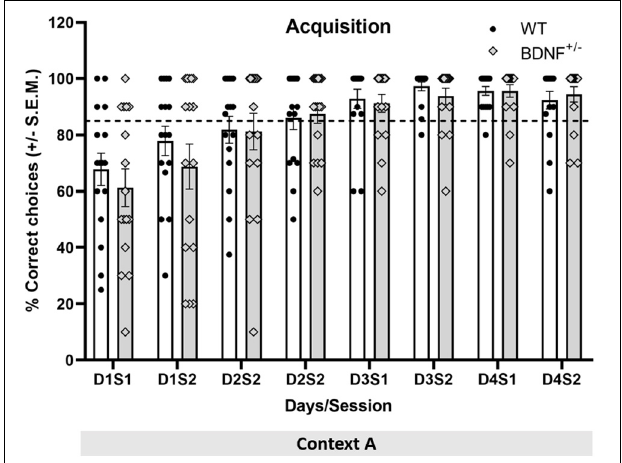
FIGURE 2 | BDNF + / − mice do not exhibit impairments in task acquisition. The bar charts show the percentage of correct choices made by the animals during task acquisition learning over 4 days in context A. Each bar pair shows the animals’ correct choice performance in a given session (S) on a specific day (D) of acquisition. White bars show the response of wild type (WT) mice and gray bars show the response of transgenic BDNF + / − mice. The dots (black: WT, gray outlined: BDNF + / − ) show the distribution of choice performance in a specific session. Both WT ( n = 16) and BDNF + / − animals ( n = 16) acquired the task over the 4 days, as signified by the increasing percentage of correct responses in both groups. Despite the gradual reduction in the reward probability, the two groups reached the 85% criterion of correct responses (dashed line) by day